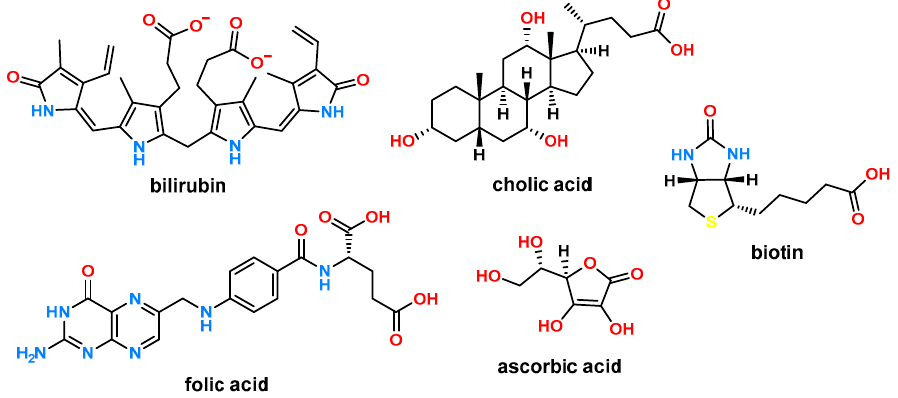
Figure 1. Examples of bioactive compounds having a carboxyl group.